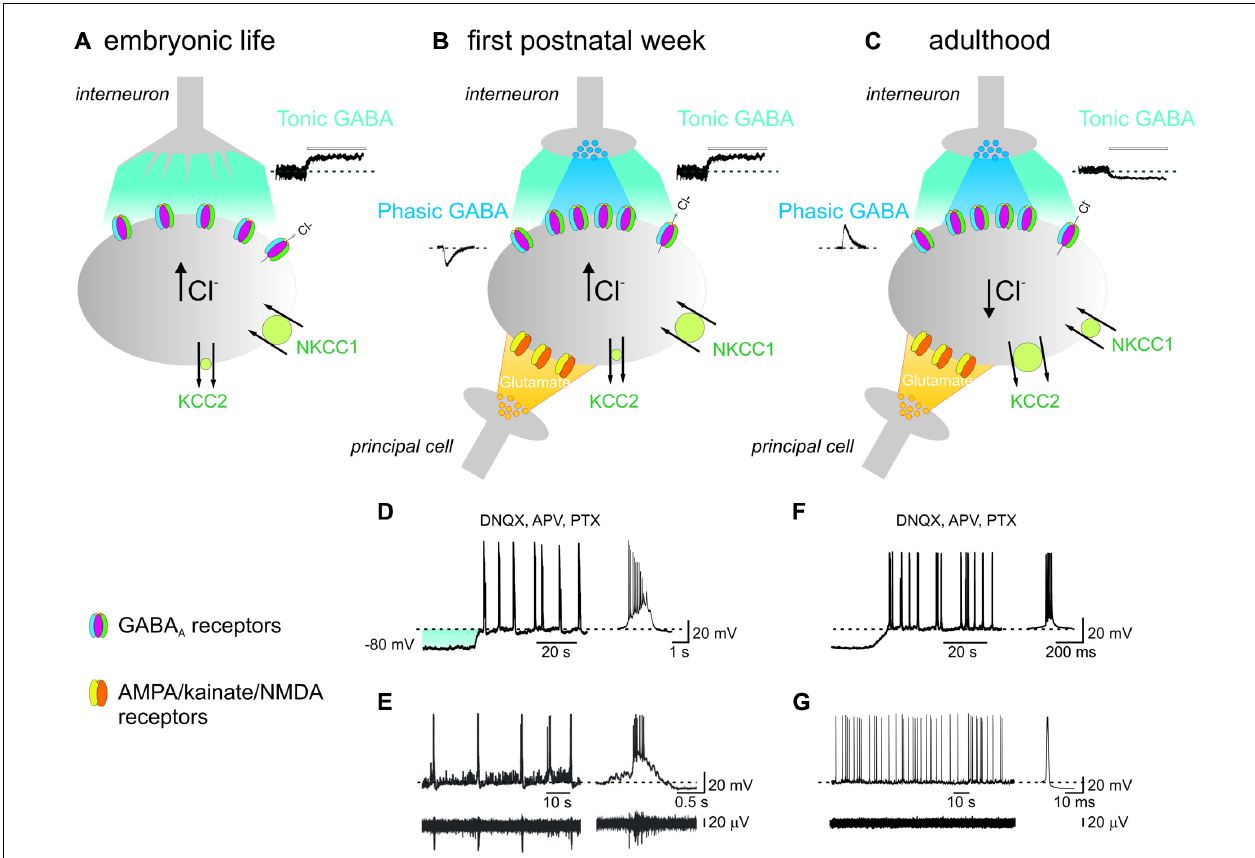
extruder KCC2 expression (large circle in green), [Cl − ] i is maintained at very low levels and when GABA opens GABA A receptor channels, causes a net flux of chloride inside the cell leading to membrane hyperpolarization and inhibition of cell firing. In addition, the concomitant down-regulation of the cation-chloride importer NKCC1 with age (small circle in green), contributes to maintain a very low [Cl − ] i . Note the opposite direction of both phasic (inset on left) and tonic (inset on the right) GABA and the reduced amplitude of the latter respect to neonates. (D) During the first postnatal week, depolarizing the membrane in the presence of AMPA/kainate/NMDA and GABA A receptor antagonists (DNQX, APV, and PTX), induces the appearance of intrinsic voltage-dependent bursts which are instrumental in triggering GDPs (see text). On the right a single burst recorded on an expanded time scale.The shadow (light blue) represents the membrane depolarization induced by tonic GABA. (E) Individual whole cell (neonatal CA3 pyramidal neuron; upper trace) and concomitant extracellular field recordings of spontaneous network-driven GDPs (bottom trace). On the right a single GDP and a concomitant field potential are represented on an expanded time scale. (F) Intrinsic bursts induced in adulthood by depolarizing the membrane in the presence of DNQX, APV, and PTX. Note the difference in burst duration between adults and neonates. (G) Whole cell (upper trace) and concomitant extracellular recordings (bottom trace) obtained from an adult CA3 pyramidal cell. On the right a single spike is shown on an expanded time scale. Note the absence of network-driven correlated activity such as GDPs ( D and F modified from Safiulina etal., 2008; E modified from Ben-Ari etal.,